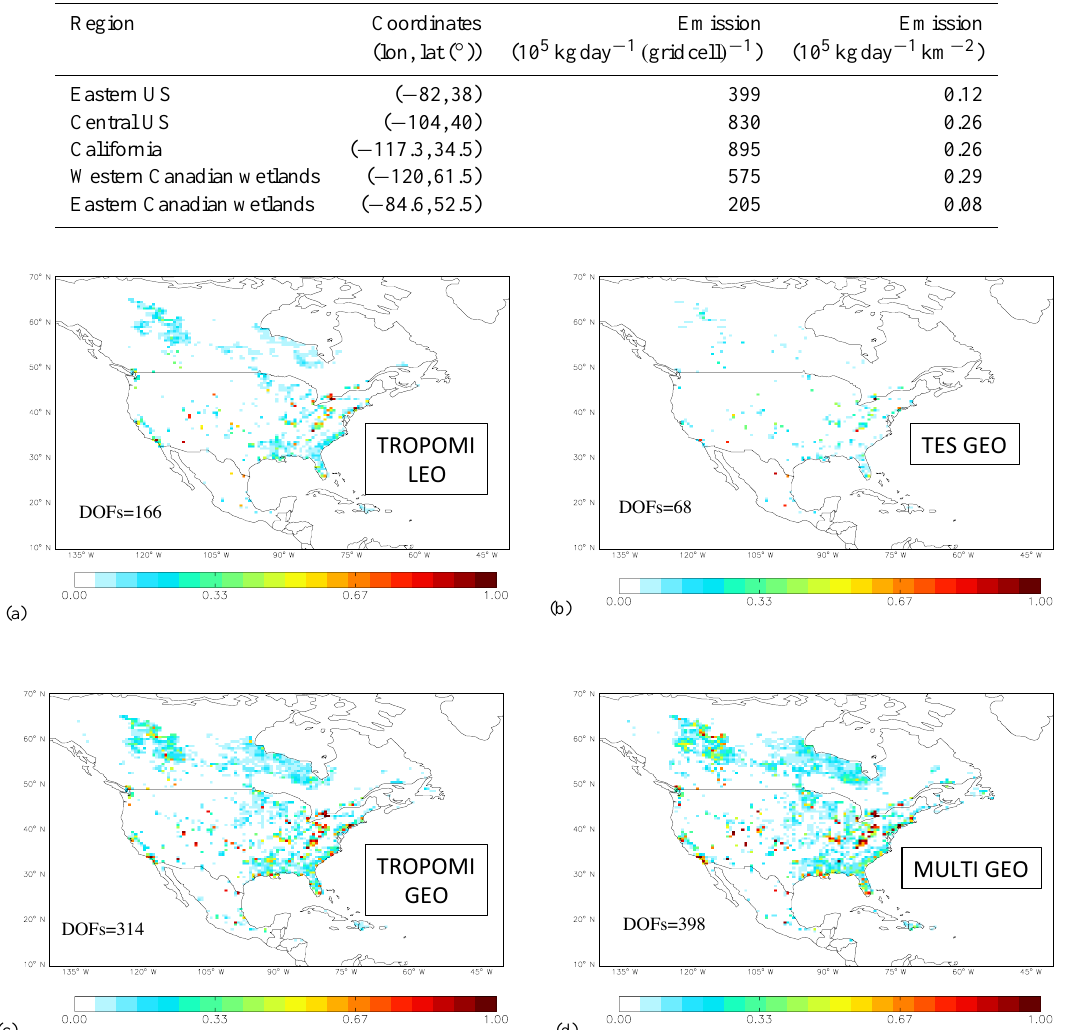
Table 1. Coordinates of the five locations considered for the rows of the model resolution matrix, with their corresponding emission rate. Region